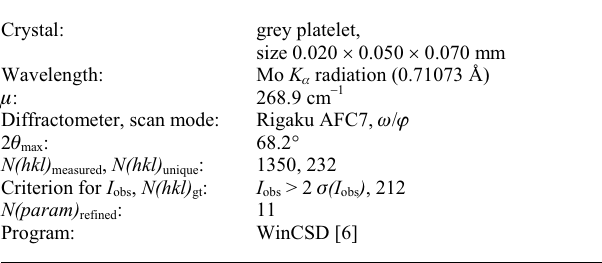
Table 1. Data collection and